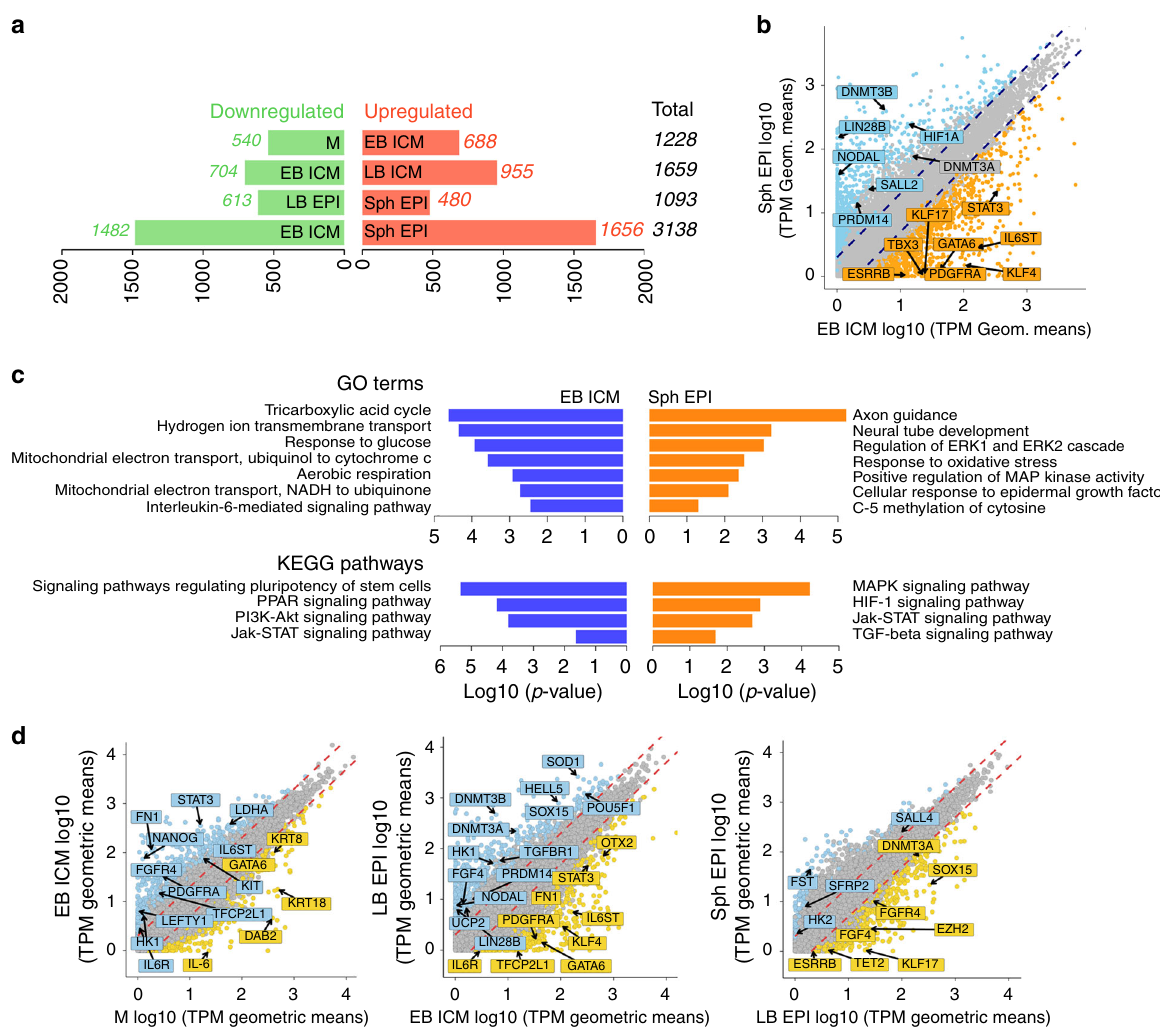
Fig. 5 Gene expression changes during progession of pluripotency. a DEGs during the progression of pluripotency. Red and green bars indicate upregulated and downregulated genes, respectively, by pairwise comparisons as indicated. b Scatter-plot of the average gene expression levels between EB ICM vs. Sph EPI (>1 fold change fl anking diagonal lines). Upregulated (orange) and downregulated (blue). Key genes are annotated. c Signi fi cant gene ontology terms and KEGG pathways in DEGs in the pairwise comparisons. d Scatter-plot comparisons of the averaged gene expression levels between M and EB ICM, EB ICM and LB EPI, and LB EPI and Sph EPI (>1 fold change, fl anking diagonal lines; orange: upregulated, blue: downregulated; log 10 (TPM geometric